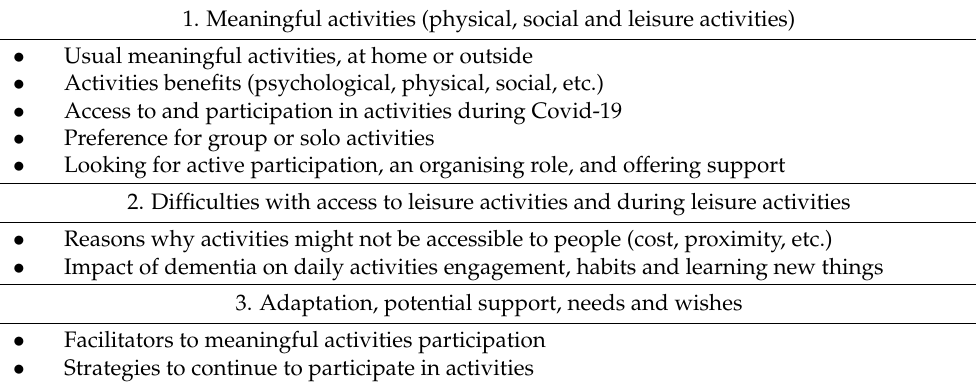
Table 2. Focus groups and interview topics